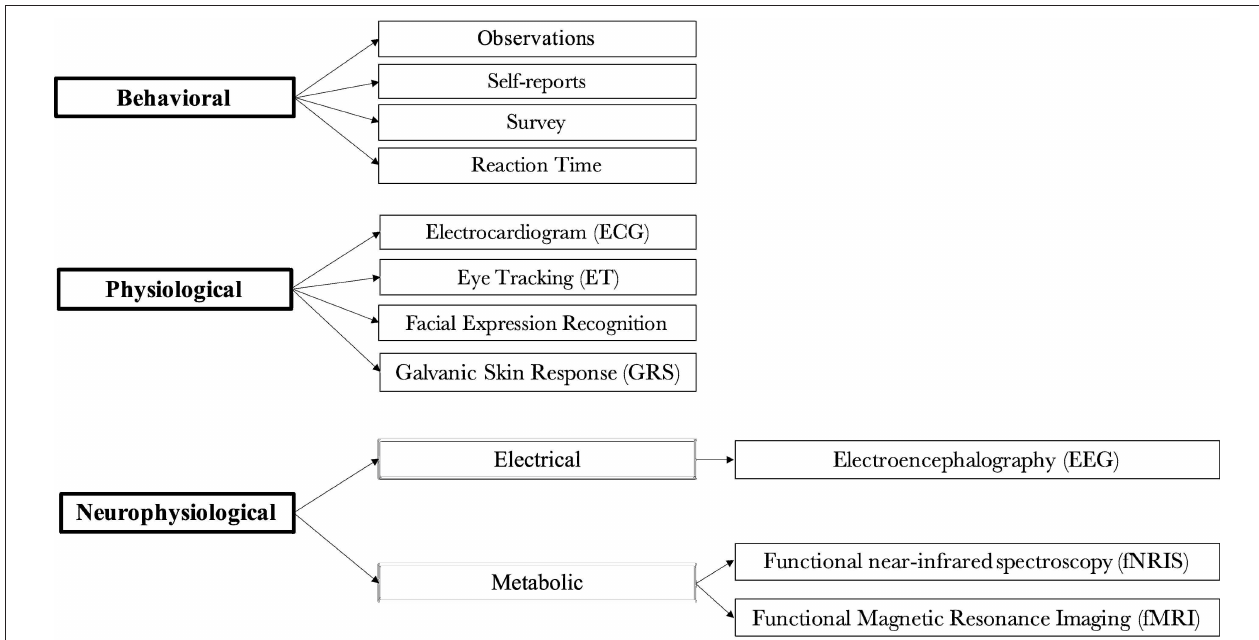
FIGURE 4 | Proposed classification of consumer neuroscience